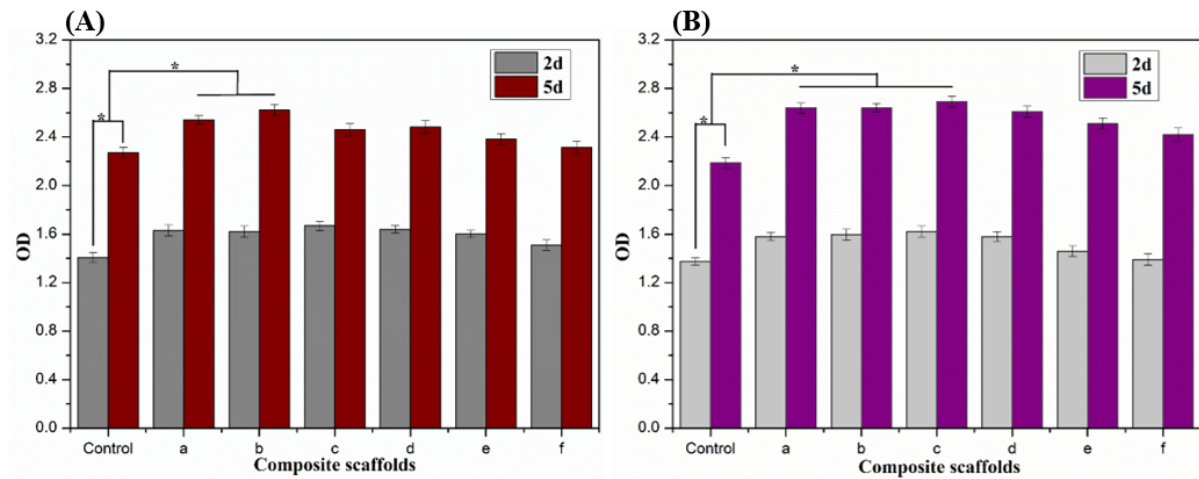
Figure 11. Cell viability of ( A ) MG63 cells and ( B ) MC3T3-E1 cells cultured on the composite scaffolds for 2 and 5 days, respectively: (a) Alg-CS-GT, (b) Alg/0.1% BCNs-CS-GT, (c) Alg/0.2% BCNs-CS-GT, (d) Alg/0.3% BCNs-CS-GT, (e) Alg/0.4% BCNs-CS-GT and (f) Alg/0.5% BCNs-CS-GT. * represents p < 0.05, indicating significant difference.